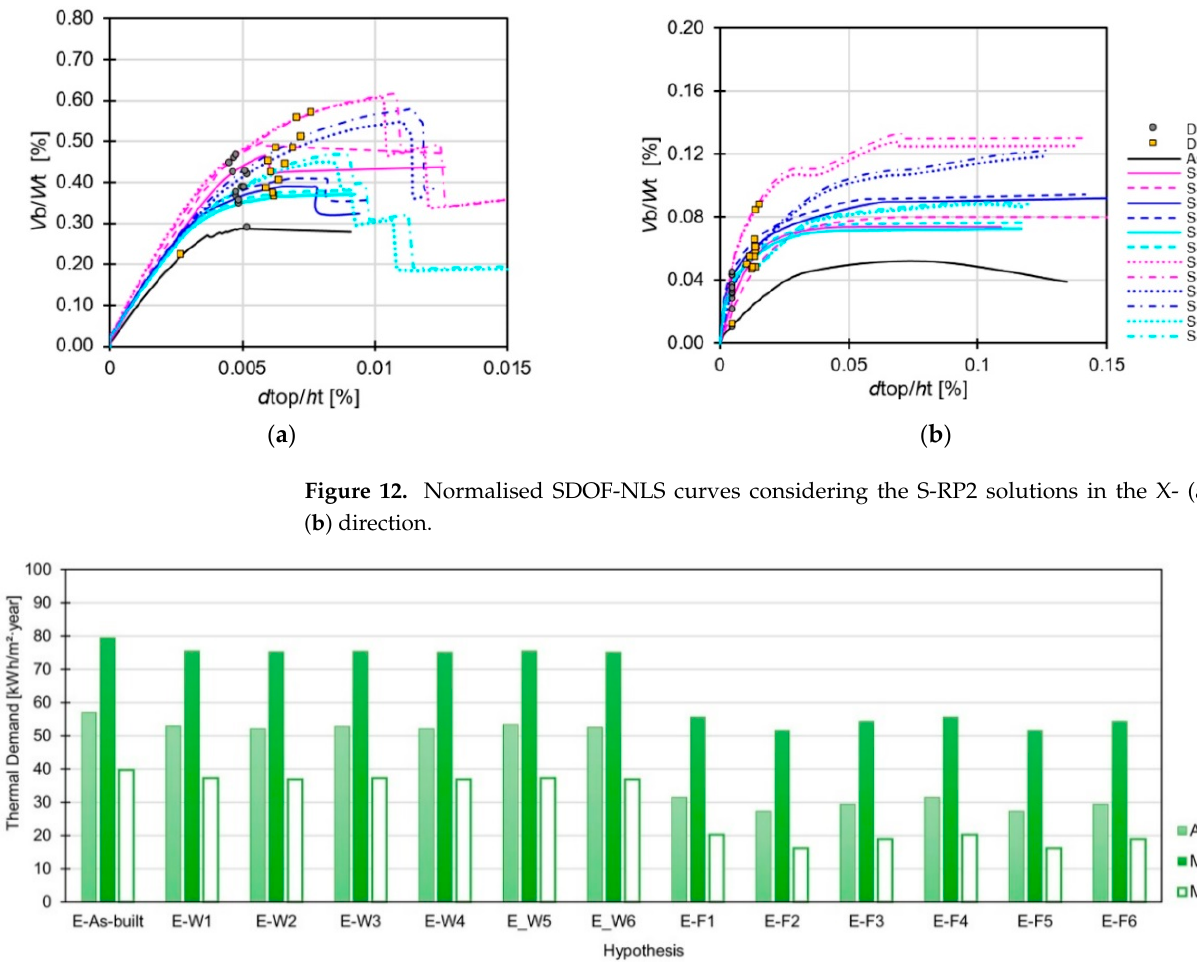
Figure 13. Annual thermal demand per m² of the hypothesis (average values of the different orientation models per hypothesis).